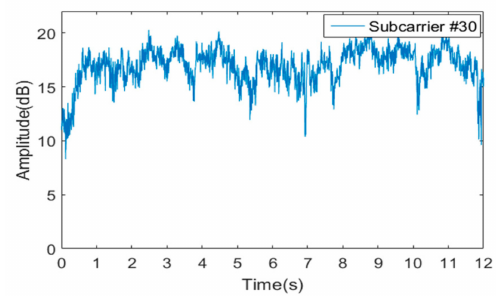
Figure 6. The original signal after removing the outliers.